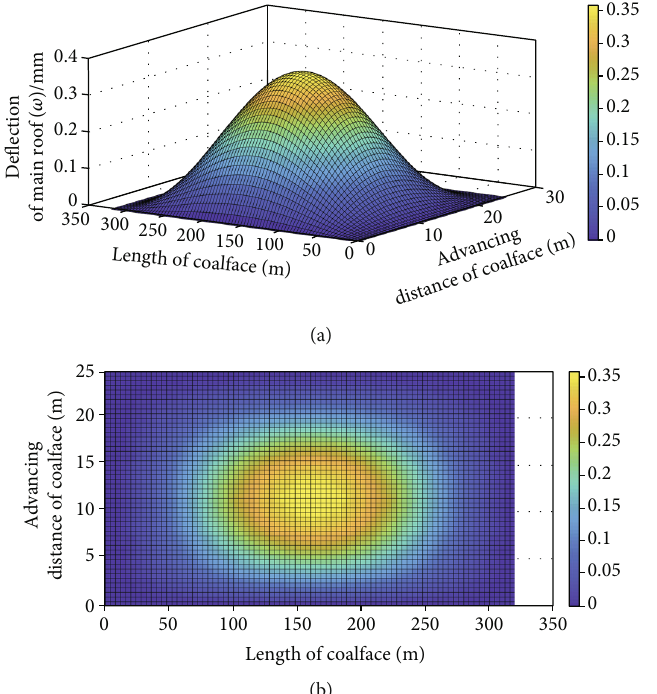
Figure 6: Characteristics of de fl ection distribution of the main roof upon periodic breaking: (a) three-dimensional distribution and (b) planar distribution.